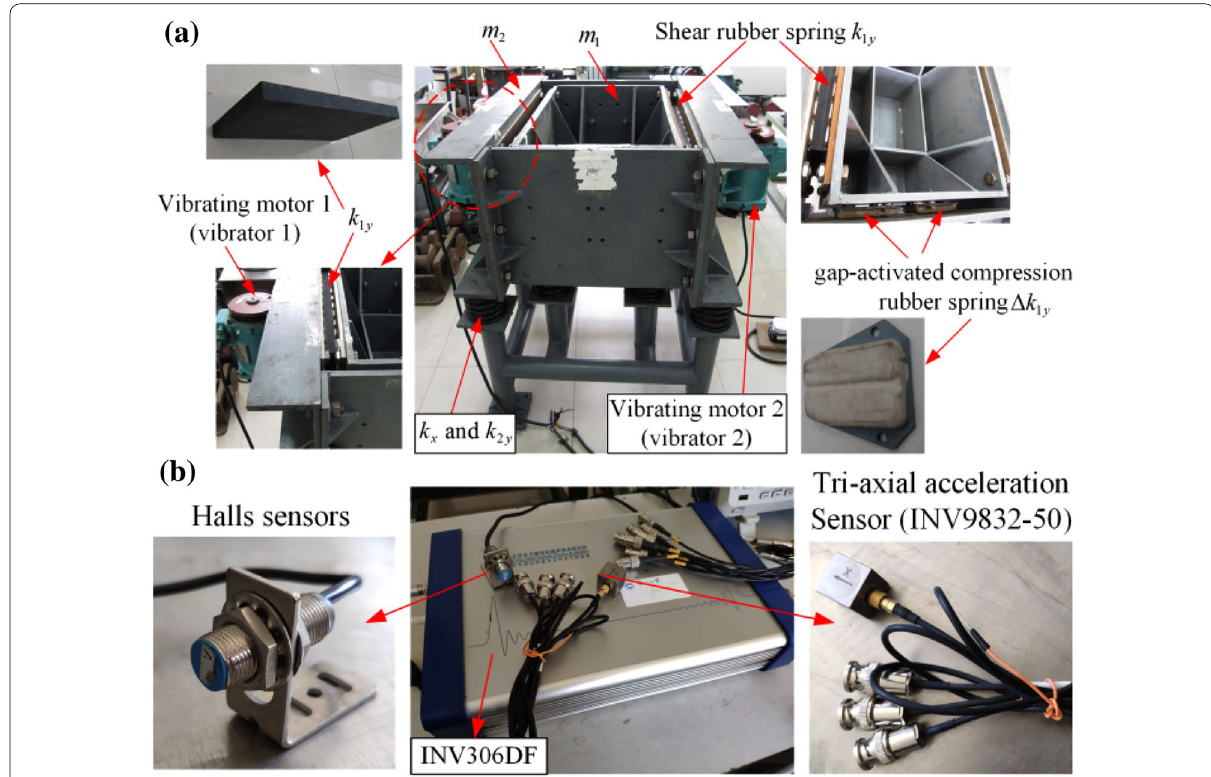
Figure 6 Synchronization bedstand with two vibrators and the corresponding testing instruments: a Synchronization bedstand; b Testing